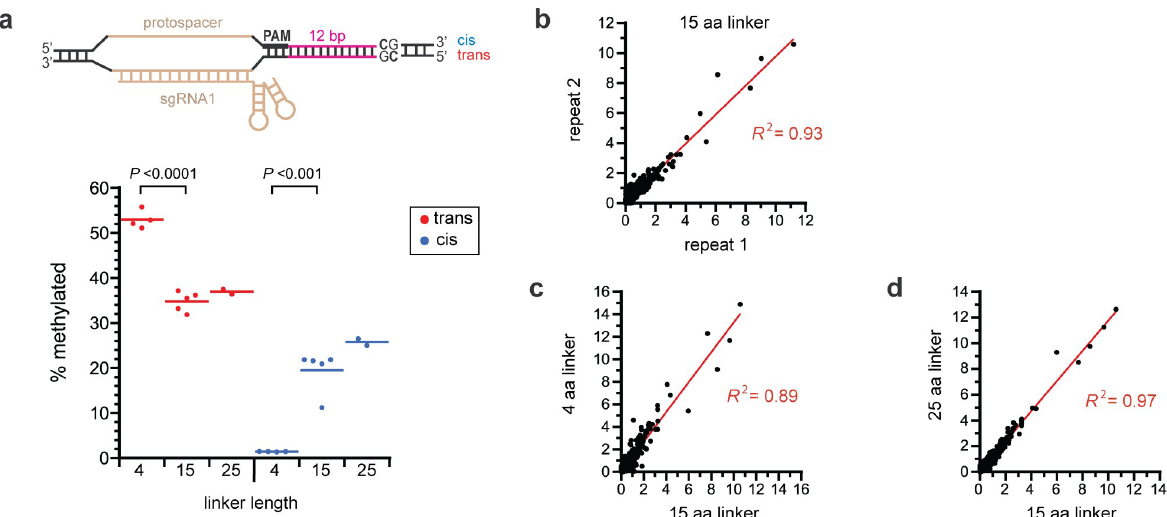
Fig 3. Effect of linker length on methylation at the target site and at non-target sites. (a) Frequency of methylation caused by dCas9-MC/MN with different linkers at the target CpG site at a gap length of 12 nucleotides from the PAM site. The P values are from Student’s t -tests ( n = 4 for the 4-amino acid linker and n = 5 for the 15-amino acid linker). Four of the five measurements for the 15-amino acid linker are from [13] and one is new. (b) Reproducibility of the frequency of methylation at 482 C’s in 241 non-target CpG sites on plasmid pReporter. Data is for the 15-amino acid linker (repeat 1 is from our previous study [13]; repeat 2 is new). (c) Correlation of off-target methylation levels when using a 4-amino acid linker and 15-amino acid linker. (d) Correlation of off-target methylation levels when using a 15-amino acid linker and 25-amino acid linker. Frequencies were determined by high-throughput bisulfite